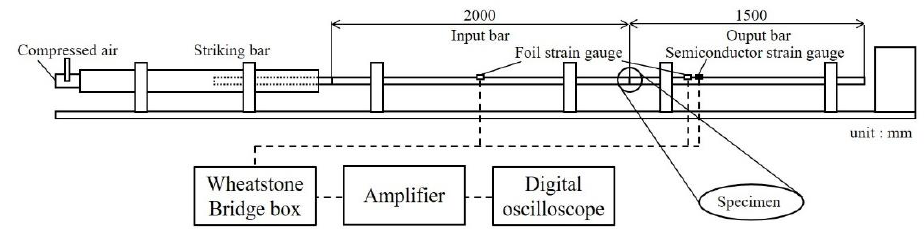
Fig. 1. Schematic diagram of split Hopkinson pressure